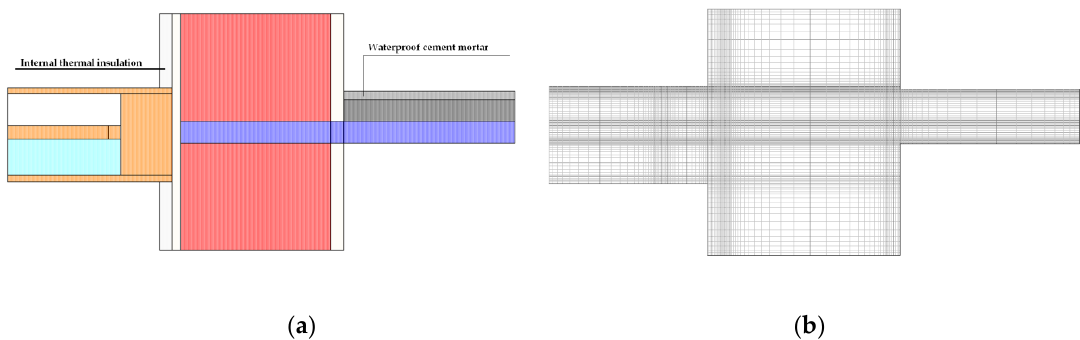
Figure 27. ( a ) Geometric model ( b ) Geometric model with a FEM (Finite Element Method) mesh (example for the alternative with internal insulation). The other materials as the same as in Figure 13.